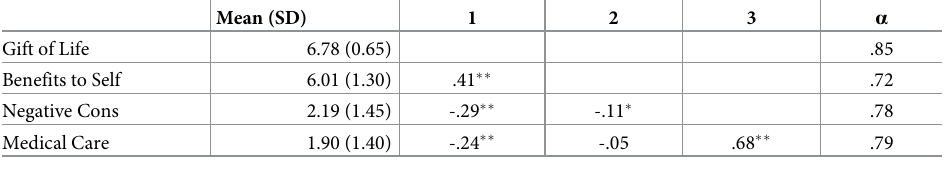
Table 4. Means ( SD ), Pearson Product-Moment correlations and Cronbach’s alpha for the Beliefs about Organ Donation sub-scales ( N = 330) .